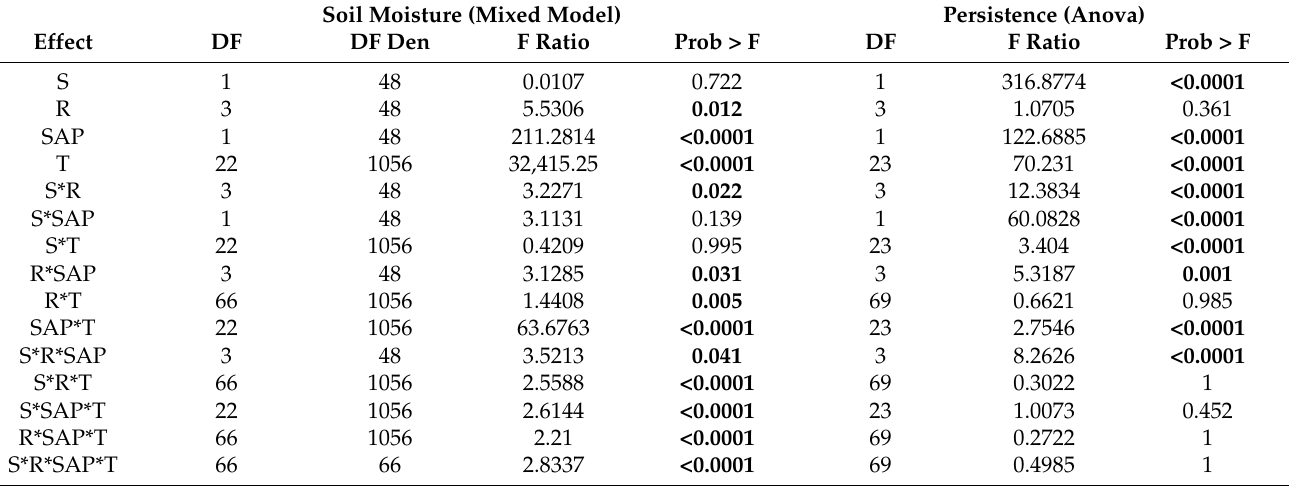
Table 5. Statistical results of a glass house study evaluating the effect of species (S), seeding rate (R), SAP rate (SAP), time (T), and their interactions on soil moisture and persistence (percent of plants alive) each day. Bolded numbers indicate p <